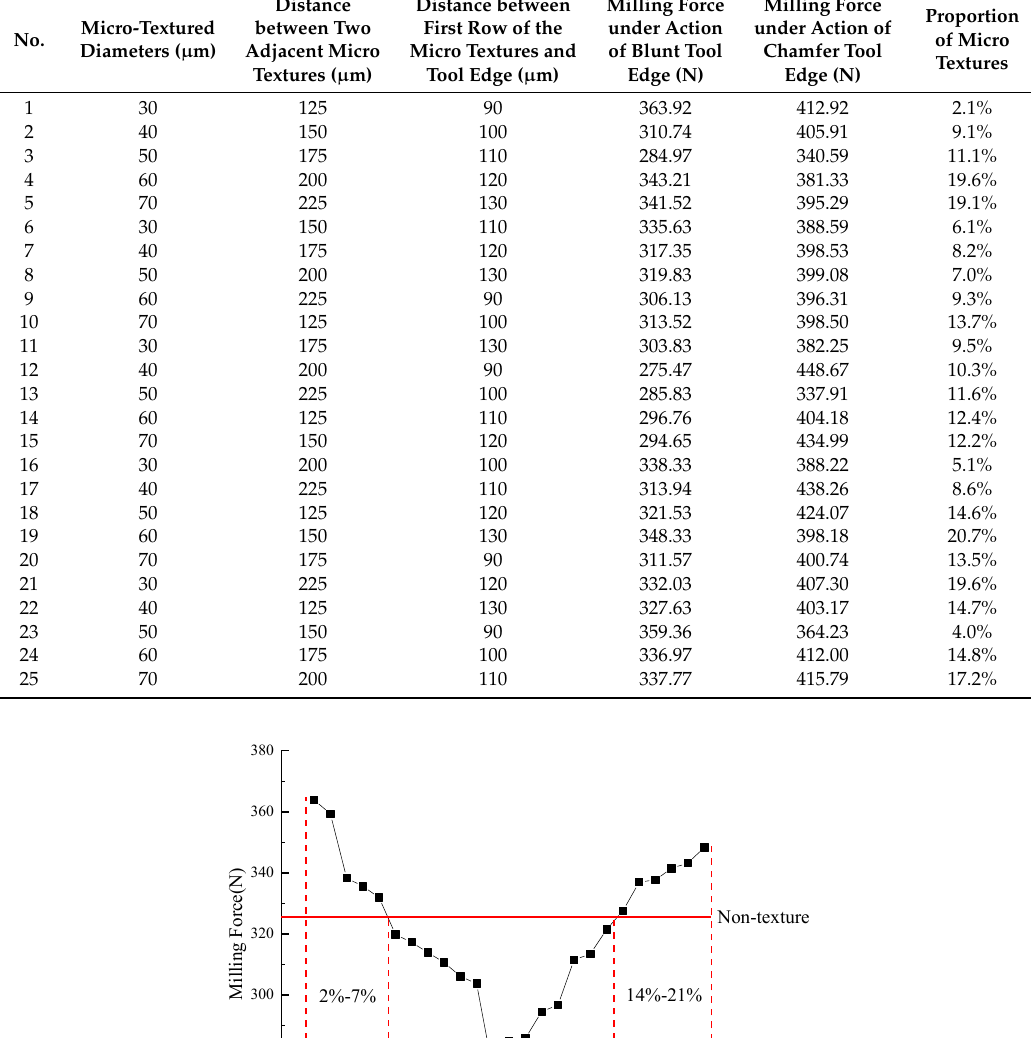
Table 8. Experimental data of milling force of micro-textured ball-end milling tools under actions of di ff erent tool edges.